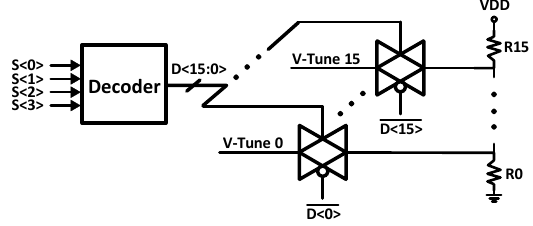
Figure 3. The fine-gain step bias trimming circuit.